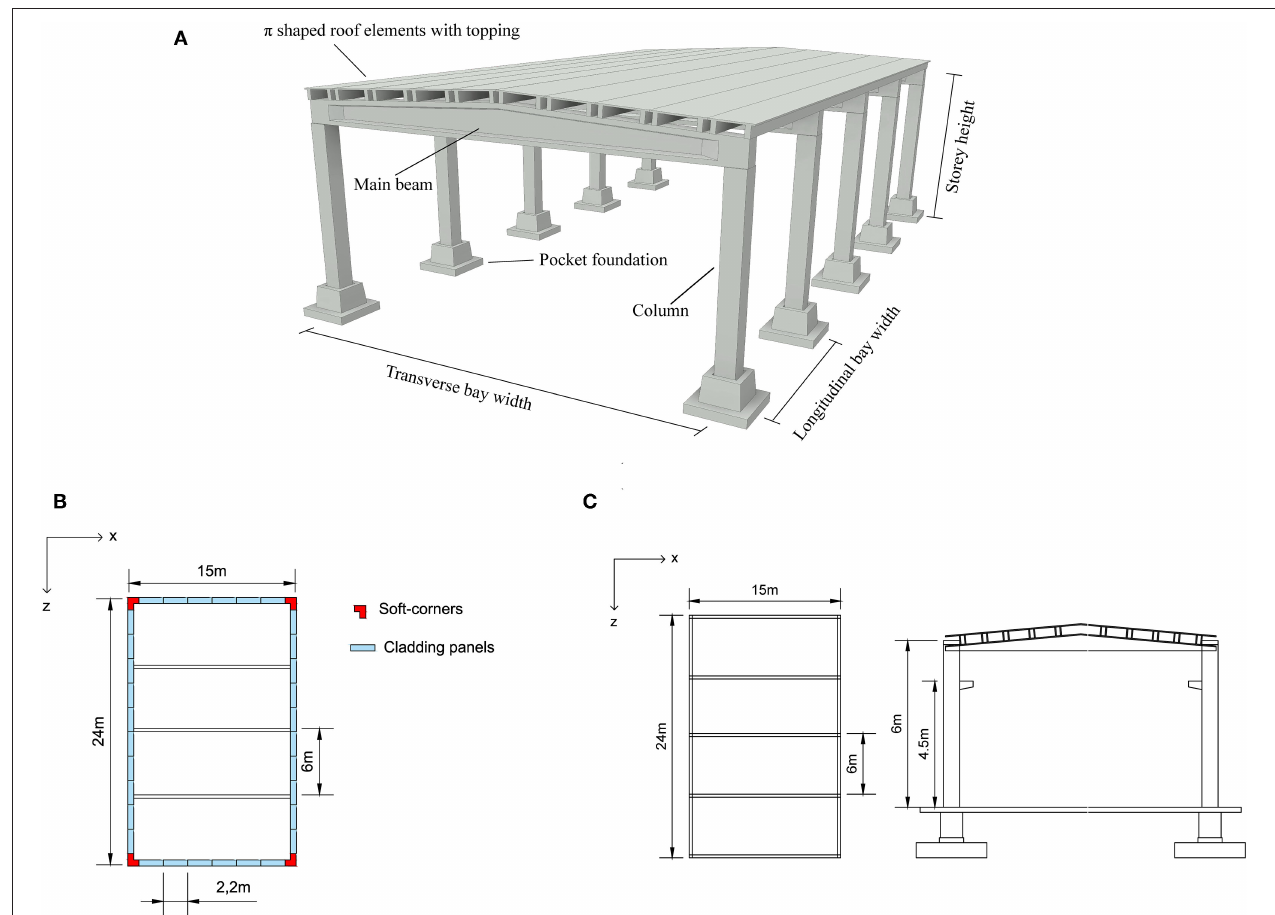
FIGURE 1 | (A) 3D view of the frame structure without cladding panels, (B) plan view, and (C) transversal cross section of the